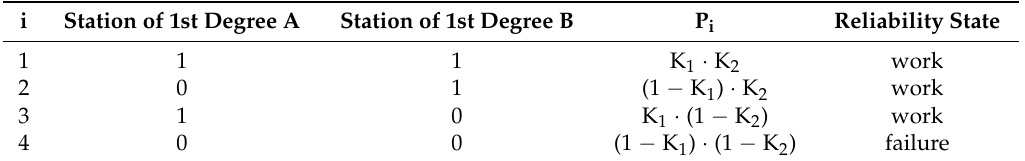
Table 2. The probabilities Pi in respect of particular reliability states.